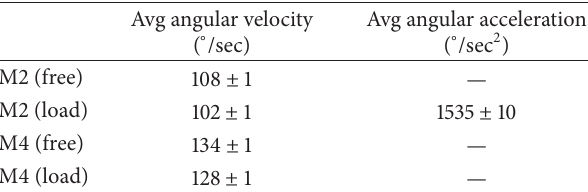
Figure 4: The first prototype exoskeletal position sensing harness, which is worn around the extended arm of a human operator. All parts used for the assembly were manufactured by the developers to design requirements. Table 1: Experimental results of average angular velocity and acceleration measurements from the robotic arm. Motor M2 moves the shoulder joint, M4 moves the elbow. The load used was